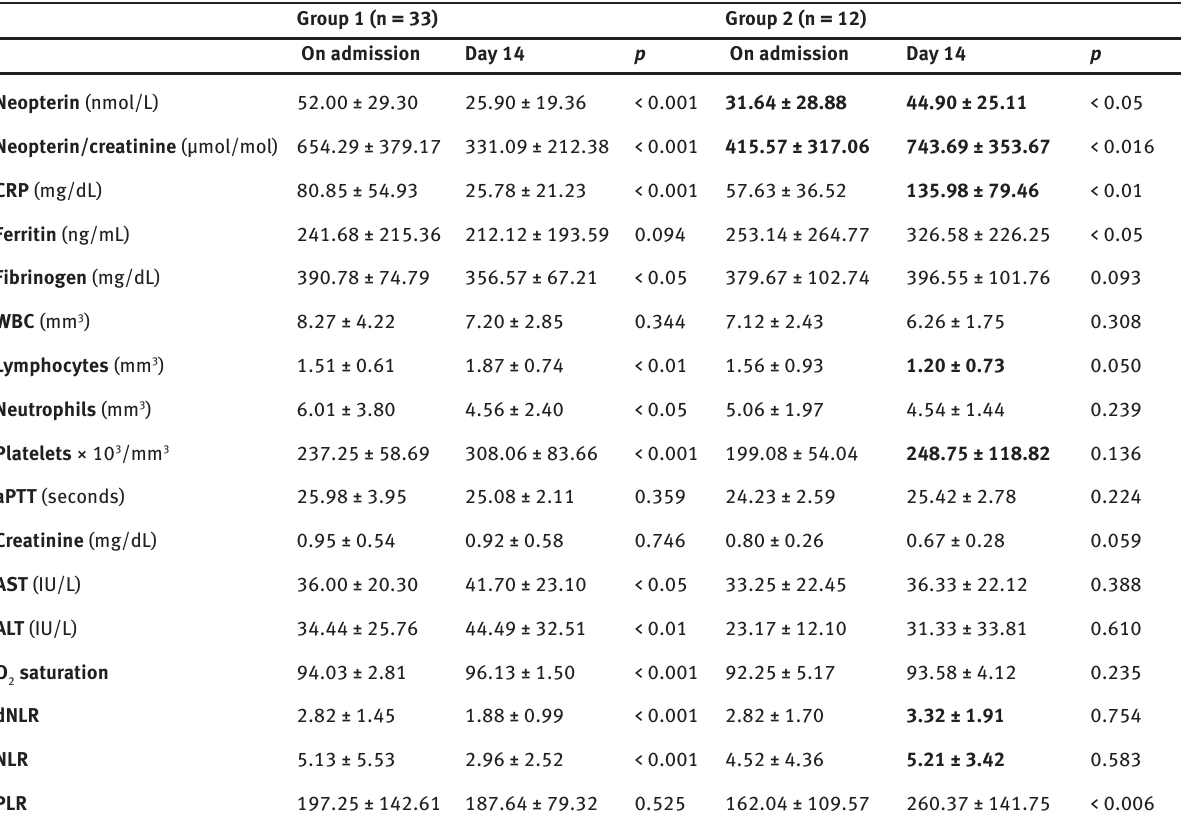
Table 2: Comparison of changes in parameters in the two groups over 14 days Group 1 (n =